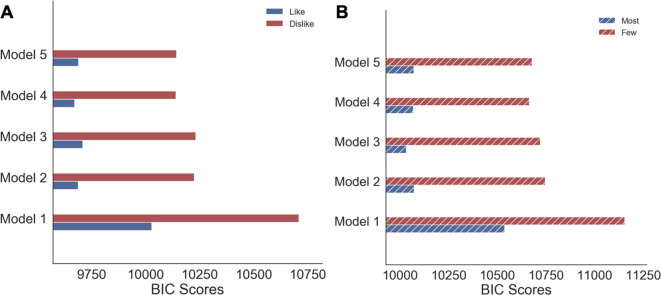
Model comparison of hierarchical linear regressions for confidence.(A) Value and (B) Perceptual Experiments. Solid colour indicates the value-based experiment and striped colours indicate the perceptual experiment.